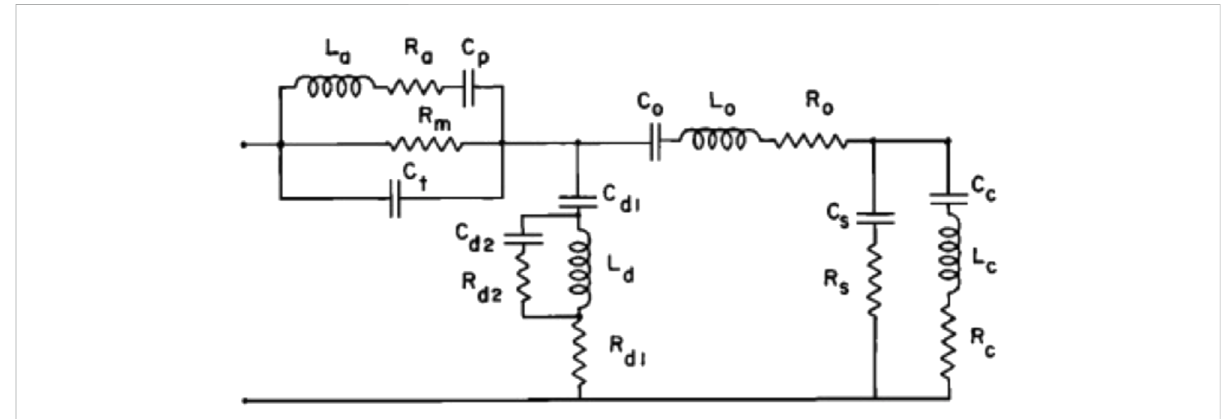
FIGURE 9 Electricanalogofthemiddleear;reprintedwithpermissionfromZwislocki(1962).ElectricelementsareLforinductance,Rforresistance,andC forcapacitance.Elementswithsubscripts a,p,m ,and t representthemiddleearcavities,thosewith d representaportionofthetympanicmembrane, and those with o represent the mallear